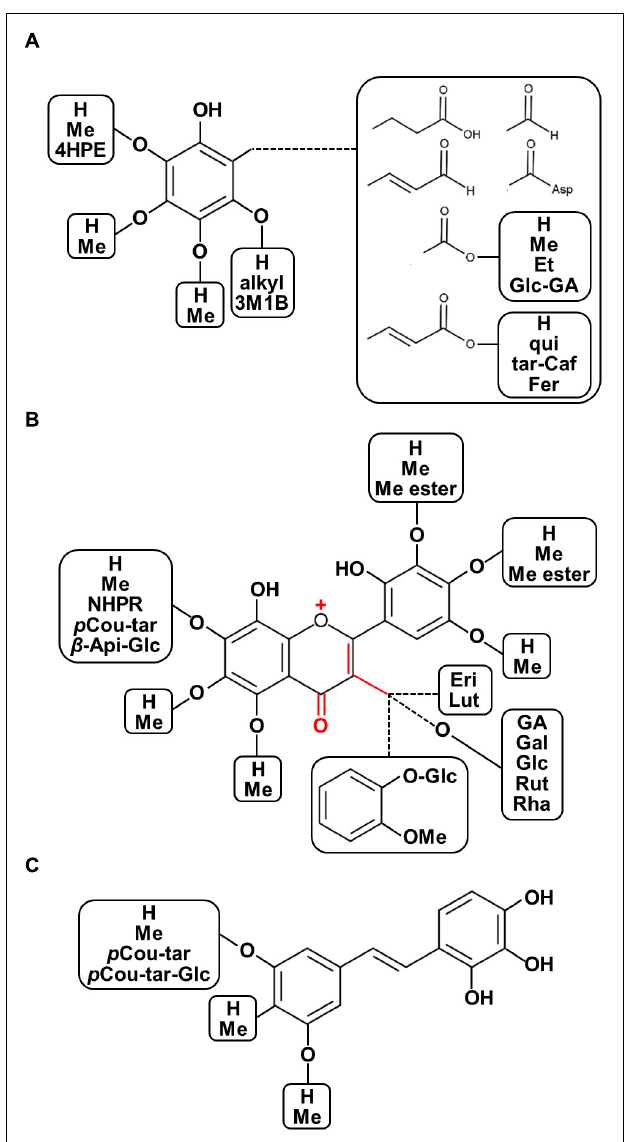
FIGURE 3 | Diversity of chemical structures of polyphenolics found in seeds of nut plant species. (A) Phenols and phenolic acid derivatives, (B) flavonoids, and (C) stilbenoids. Abbreviations: OMe, methoxy; 4HPE, 4-(hydroxypheny)ethylene; Asp, aspartate; Me, methyl; Et, ethyl; qui, quinic acid; tar, tartaric acid; fer, ferulic acid; 3M1B, 3-methyl-1-butenyl; p Cou-tar, p -coumaroyl-tartarate; p Cou-tar-Glc, p -coumaroyl-tartarate-glucoside; Pre, isoprenyl group; Me ester, methyl ester; NHPR, neohesperidose; Api-Glc, -apiosyl-glucose; Eri, eriodictyol; Lut, luteolin; GA, gallic acid; Gal, galactose; Glc, glucose; Rut, rutinose; and Rha,